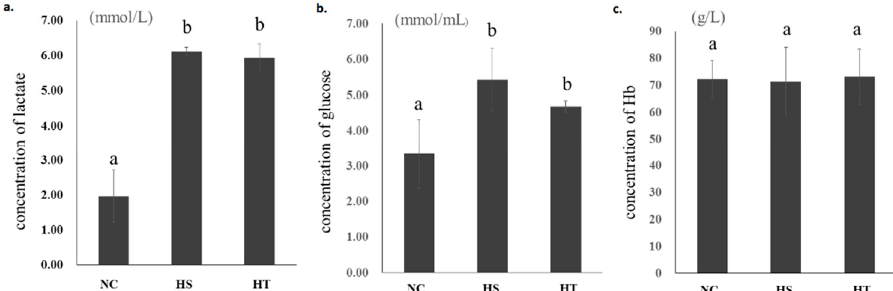
Figure 1. Glucose ( a ), lactic acid ( b ), and hemoglobin (Hb) ( c ) concentrations in blood samples of the normoxia control (NC), hypoxaia sensitive (HS), and hypoxia tolerant (HT) groups of bighead carp. a,b Means with different letters differ significantly between control and hypoxia stress groups